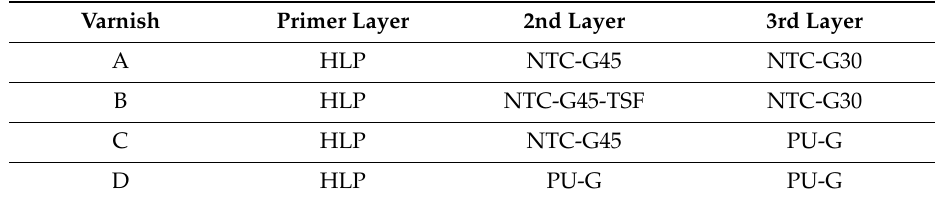
Figure 1. Experimental setup (photo): ( a ) electronic control unit with four independent ports, ( b ) stereo-microscope, ( c ) micromanipulator, ( d ) flume, ( e ) pairs of painted plates with red and black contacts and a reference pair of electrodes coated with Varnish A but without electrical contacts; insert: ( f ) pH probe. Experiment 1 (red frame): temporal development of pH at the surface of four paints (see Table 1 for paints A–D). Periods of positive and negative charges are marked in red and blue, respectively. Experiment 2 (blue frame): time schedule of the electrolysis current (I–IV). Table 1. Properties of the used coating samples A–D. HLP: Hempel Light Primer, NTC: NanoTech Coatings, TSF: tetramethyltetraselenafulvalen, PU-G: polyurethane with graphite